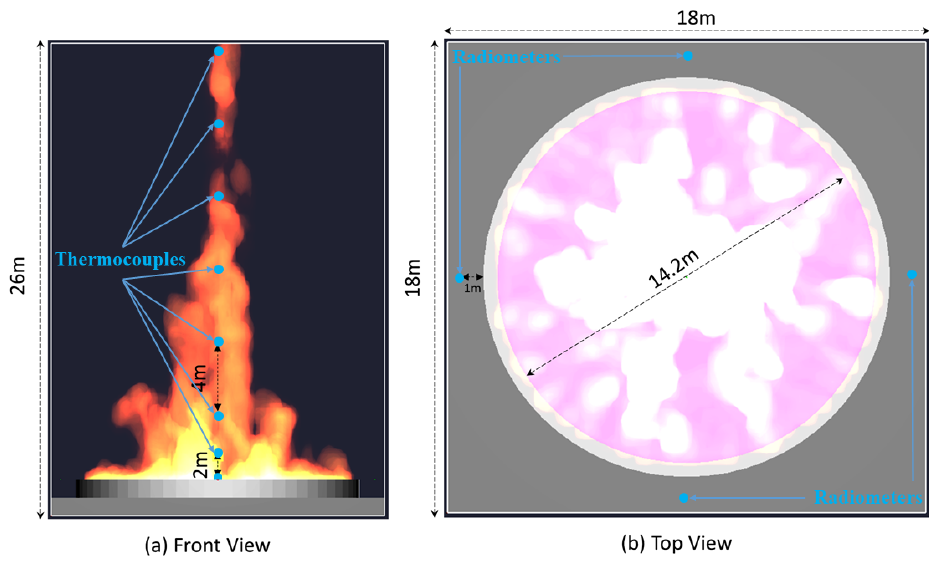
Figure 1. ( a ) Front view of the three-dimensional model design and placement of devices with an opening on the sides, ( b ) top view.